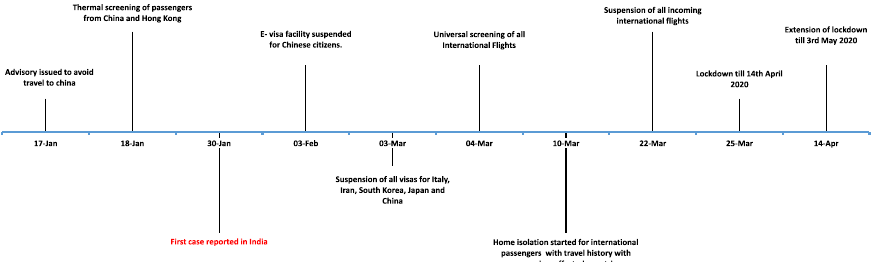
Fig. 1. The timeline of COVID-19 outbreak and the preventive measures to control the spread of COVID-19 in